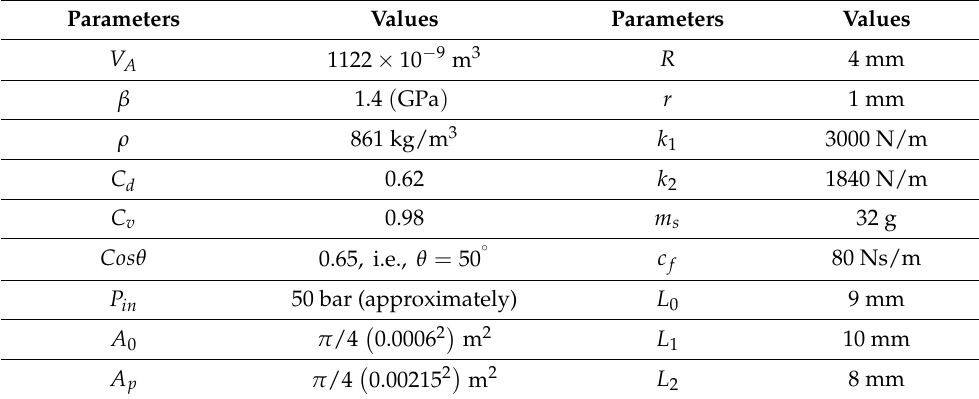
Table 1. Parameter values for valve mechanism used in this study.